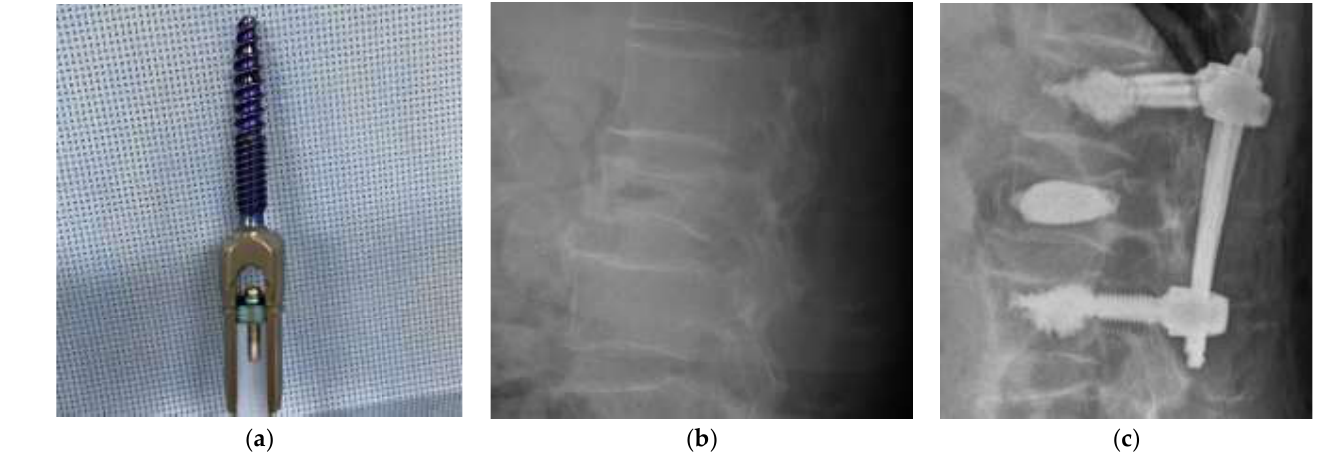
Figure 1. Fenestrated screws ( a ) Expedium Verse Ⓡ spinal system and Vertecem V+ Ⓡ cement (DePuy Synthes Products, Inc., Raynham, MA, USA), ( b ) Case illustration: preoperative lumbar X-ray, 82-year-old man with L1 vertebral fracture pseudarthrosis in the osteoporotic spine (T= − 2SD). ( c ) Case illustration: postoperative lumbar X-ray. L1vertebroplasty and T12-L2 posterior fusion with cement-augmented fenestrated screws was performed.